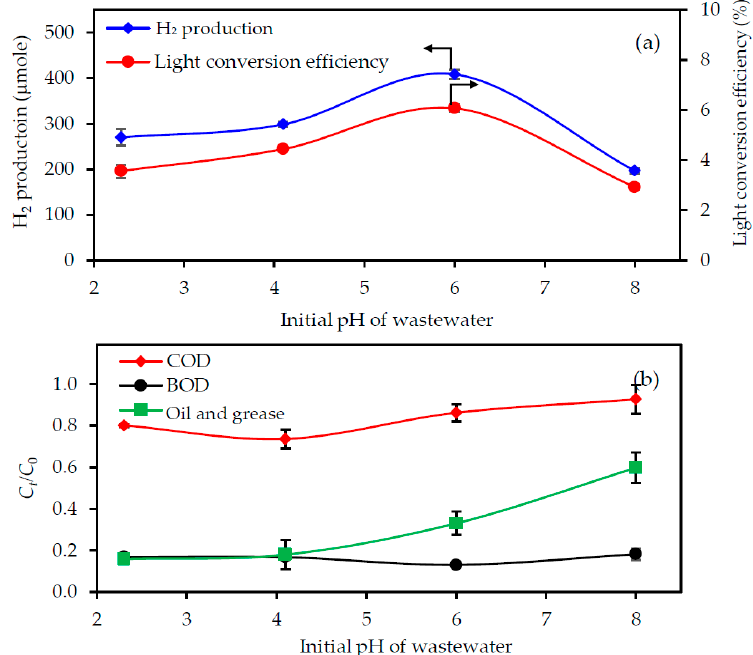
Figure 6. Effect of the initial pH of the wastewater on the level of ( a ) H 2 production with light conversion efficiency and ( b ) pollutant removal from the 3.3-fold diluted acid-pretreated biodiesel wastewater with a UV light intensity of 4.79 mW/cm 2 and photocatalyst loading of 4.0 g/L for 4 h.